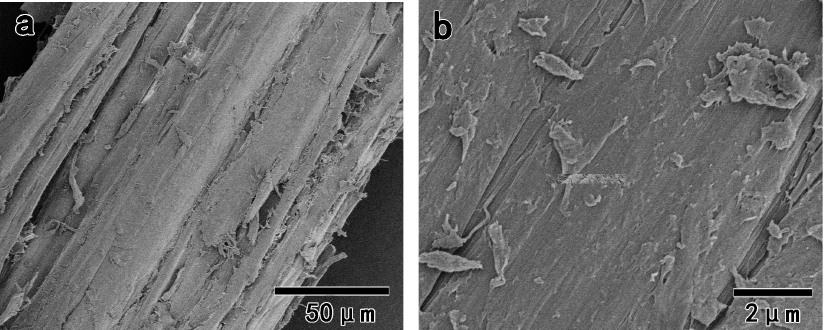
Figure 5. Field emission scanning electron microscopy (FE-SEM) images of the extracted wood fiber: ( a ) 600 × magnification; ( b ) 10,000 × magnification.